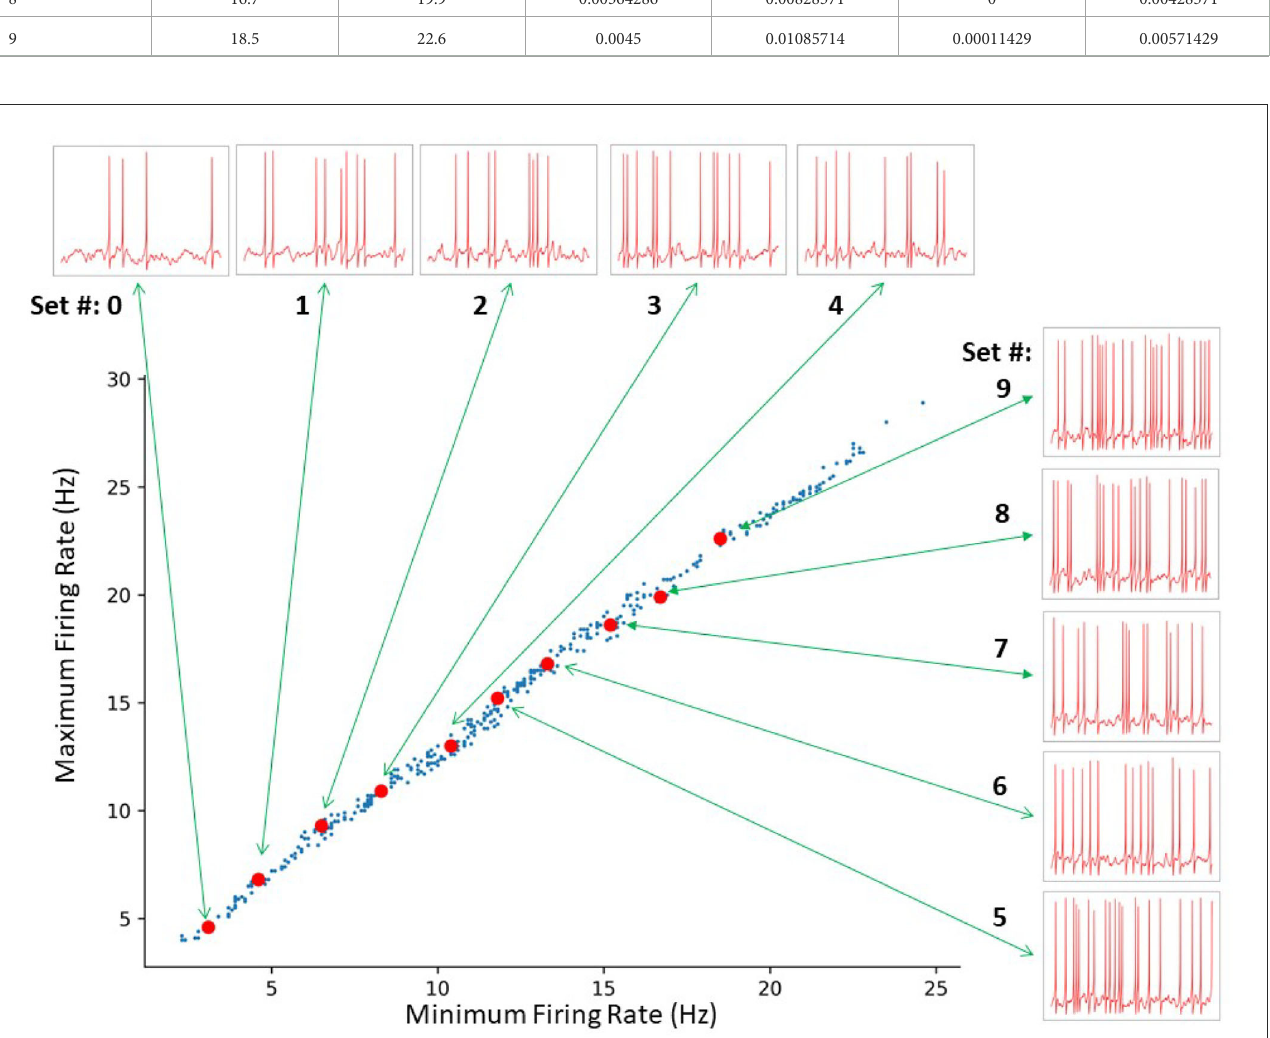
FIGURE5 SINGLE yields a wide range of in vivo -like (IVL) firing frequencies as exists in experiment. A total of 414 sets of parameters were identified by a constrained search. The red dots indicate the 10 representative sets selected for further analyses. From bottom left to top right: Set # 0–9, respectively. The green arrows connect each representative set to a 1 s voltage trace example produced using the respective representative